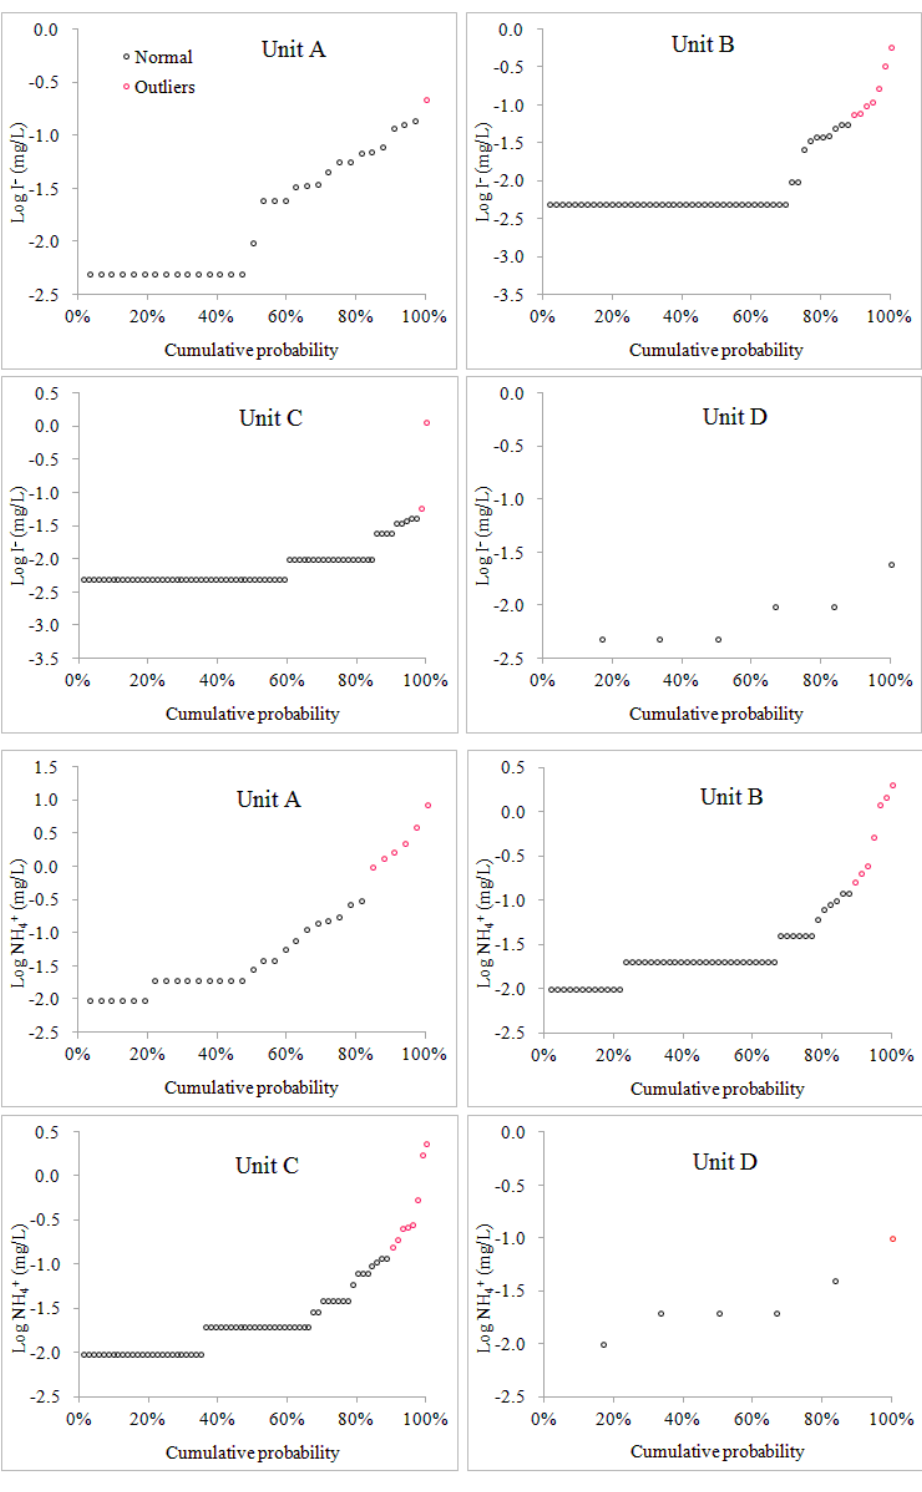
Figure 2. Outliers in the OXC datasets in various groundwater units tested by Grubbs’ test.